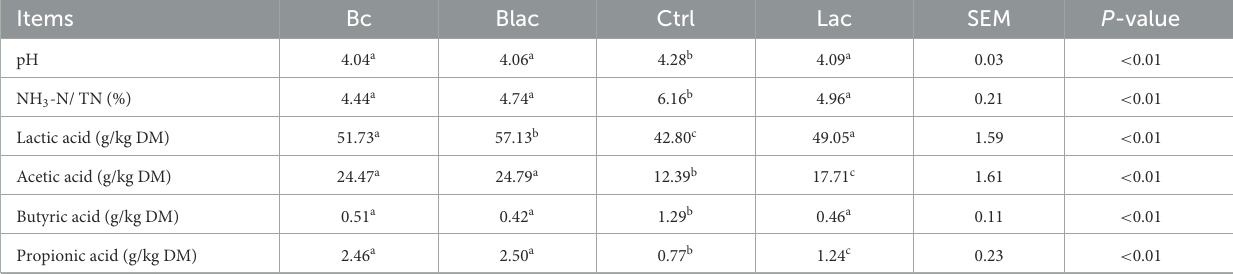
TABLE 3 Fermentation characteristics of rape silage after 60 days